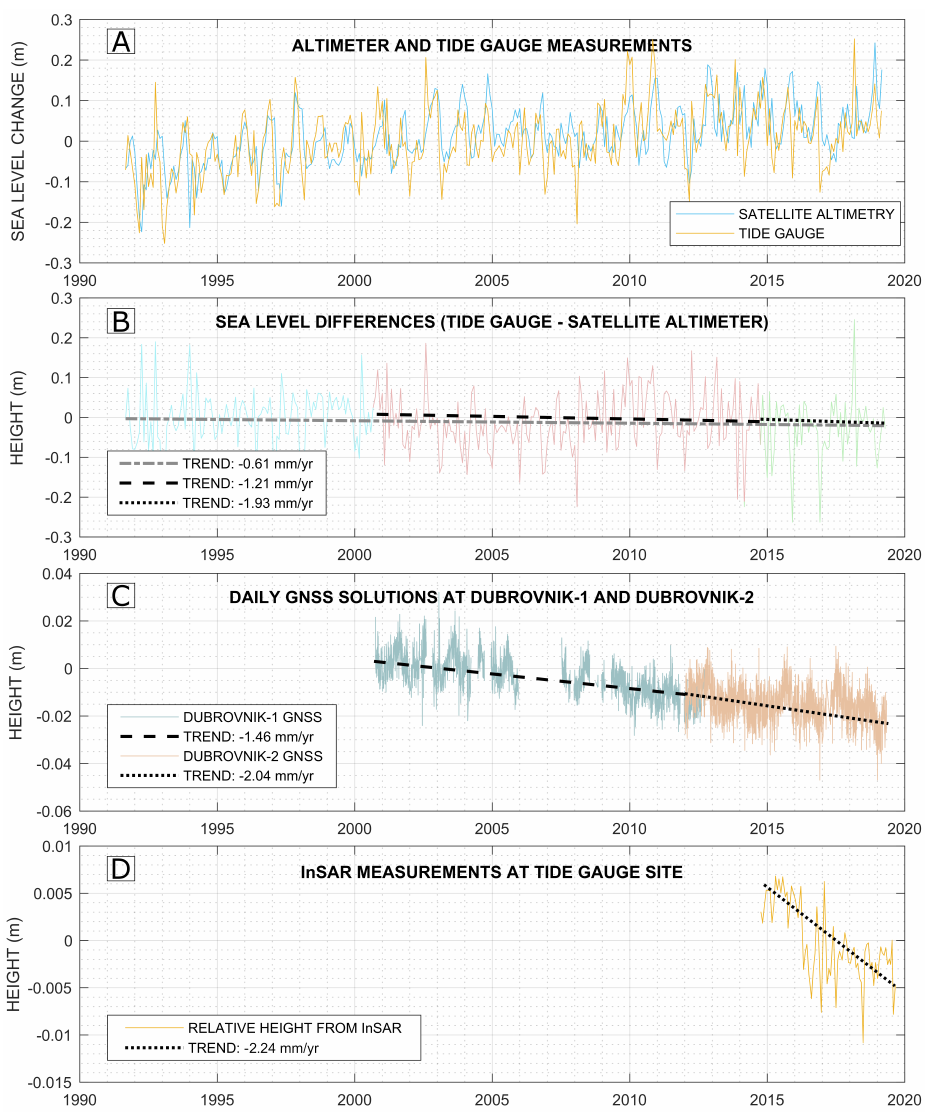
Figure 4. Processed observations and computed VLM trends; subplot A presents original filtered and processed altimeter and tide gauge data; subplot B shows the differences between the sea-level data presented in subplot A and the trends for three defined periods-from 1992 (altimeter era), from 2000 (Global Navigation Satellite System (GNSS) observation period in the study area), and from 2014 (Interferometric Synthetic Aperture Radar (InSAR) observation period); subplot C presents GNSS data obtained in Dubrovnik at two GNSS stations for the periods 2000–2012 and 2011–2020 along with the computed VLM trends for two observation periods (the same trend is computed for InSAR period, from 2014); subplot D presents an averaged Sentinel-1 InSAR measurements over the period 2014–2020 at tide gauge location with the VLM trend